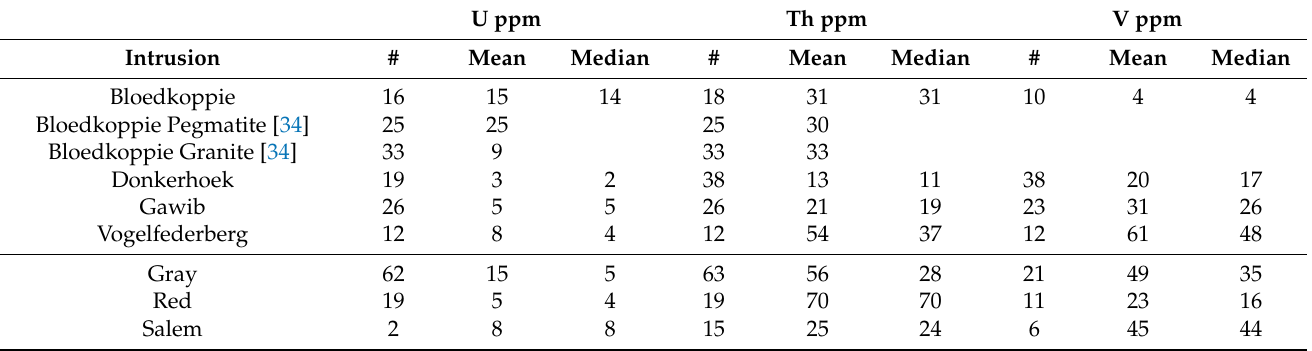
Table 2. Mean and median abundance of U, Th and V in various granites of the Erongo region. U ppm Th ppm V